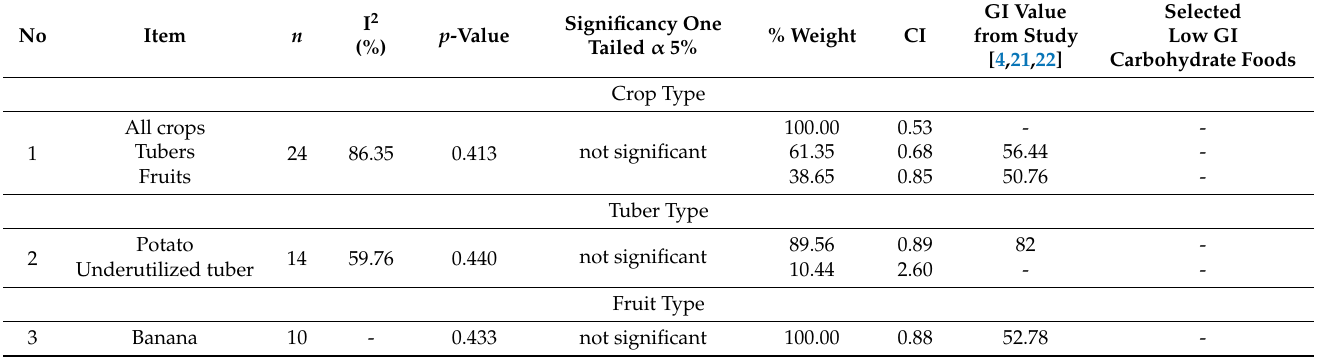
Table 7. Selected low-GI carbohydrate foods using meta-analysis in in vivo